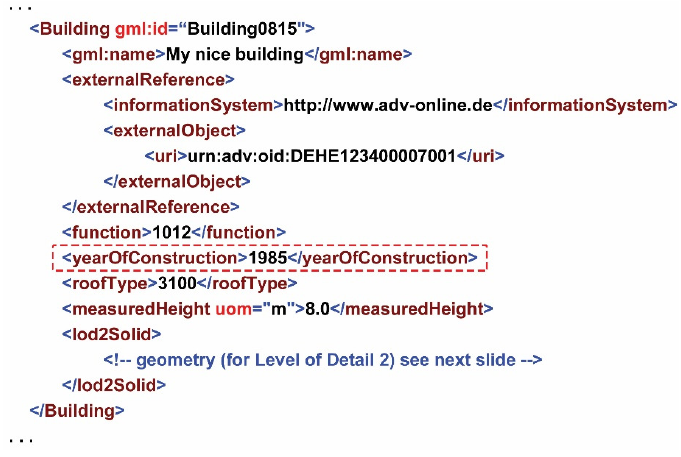
Figure 11. Structure of a simple building in CityGML [37].